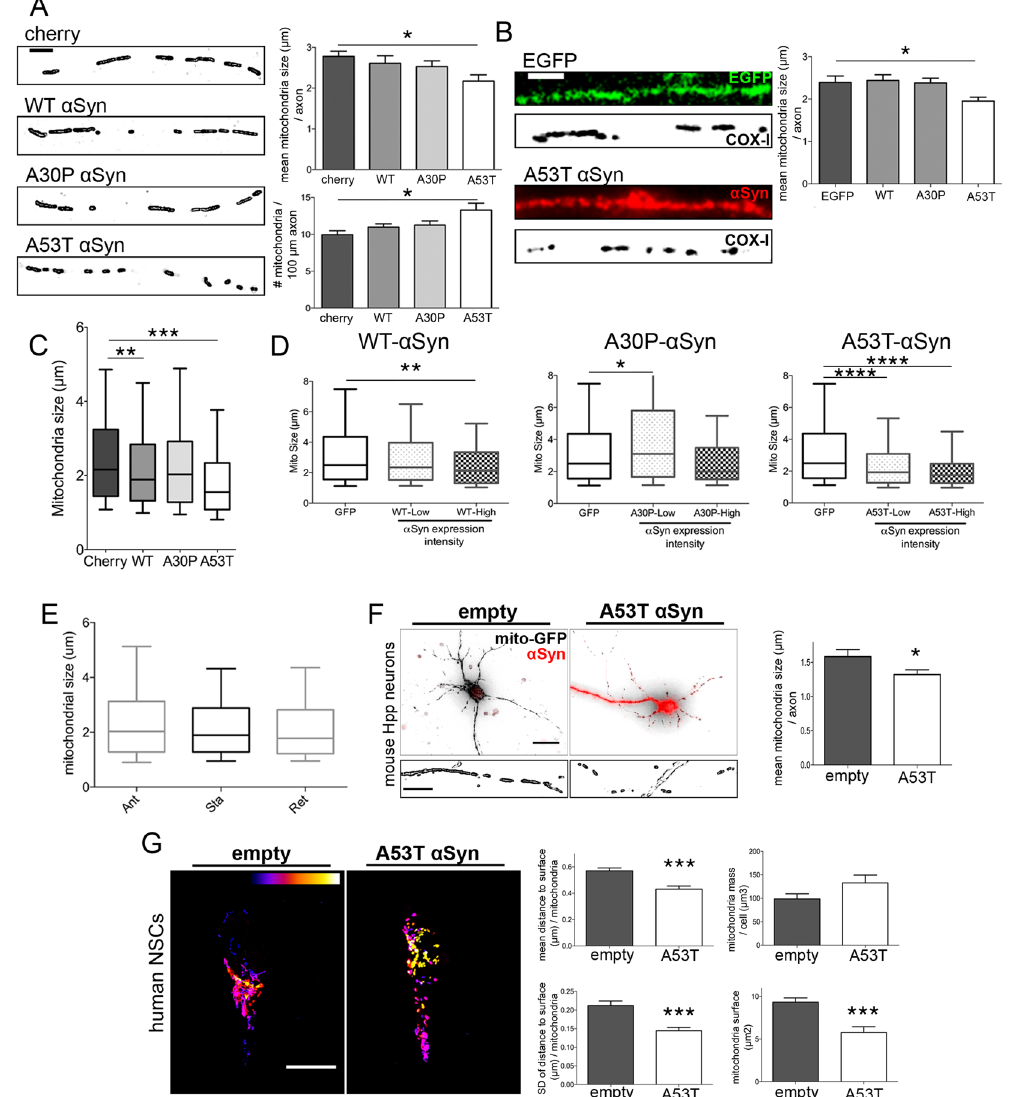
Figure 3. A53T α Syn overexpression reduces mitochondrial size and increases density in human neurons. ( A ) Mean size and density of mitochondria in axons from WT, A30P, or A53T α Syn and mito-GFP co-transfected neurons (n = 60 per condition from 10 independent experiments). Scale bar, 5 μ m. ( B ) A53T α Syn-induced mitochondrial size reductions were confirmed using immunofluorescent staining against COX-I in transfected neurons. Data is represented as mean ± SEM. One-way ANOVA followed by Dunnett’s post-test, * p < 0.05 (n = 40 from 4 independent experiments). Scale bar, 5 μ m. ( C ) A53T and, to a lesser extent, WT α Syn reduced the size of mitochondria. Data presented as median plus interquartile range. ( D ) Median and percentiles corresponding to mitochondrial size categorized by low or high α Syn (above α Syn maximum intensity of GFP only-transfected cells) fluorescence intensity on each treatment. Kruskal-Wallis ANOVA for low and high α Syn variant compared with control (p < 0.05) (n = 20 neurons). ( E ) Average mitochondrial size from different conditions pooled together for anterograde, stationary, and retrograde mitochondria. Data represented as median, 25 and 75 percentiles box, 10 and 90 percentiles whiskers. No significant differences were found. Kruskal-Wallis ANOVA (p > 0.05). (n = 2000 mitochondria from 10 independent experiments). ( F-G ) A53T α Syn effects on mitochondrial size are not limited to human neurons. ( F ) Mouse hippocampal neurons co- transfected with mito-GFP and empty vector or A53T α Syn. Inset: magnification of the axon. Scale bar, 30 μ m, inset scale bar, 10 μ m. Mean mitochondrial size quantification in axons from A53T α Syn-overexpressing mouse neurons compared with control (n = 30 axons from 3 independent experiments). ( G ) Three-dimensional analysis of mitochondrial morphology in human neural stem cells co-transfected with mito-GFP and empty vector or A53T α Syn. Color-coded bar shows mitochondrial location in z-axis. Bar graphs show reduction in mitochondrial surface, mean distance to surface, and standard deviation (SD) of distance to surface with no changes in total mass upon A53T α Syn overexpression (n = 15 cells from 2 independent experiments). Scale bar, 20 μ m. Data is represented as mean ± SEM. Paired t-test, *** p < 0.001, * p < 0.05. See also Figure